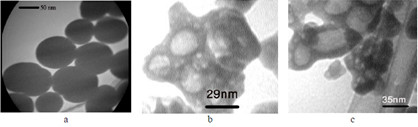
TEM images of nanoparticles. TEM images for (a) Gd2O3-DEG, (b) SPGO-mPEG-silane550, (c) SPGO-mPEG-silane2000. Uniformity and spherical or ellipsoidal shape for Gd2O3-DEG and agglomeration for two other nanoparticles are observed.